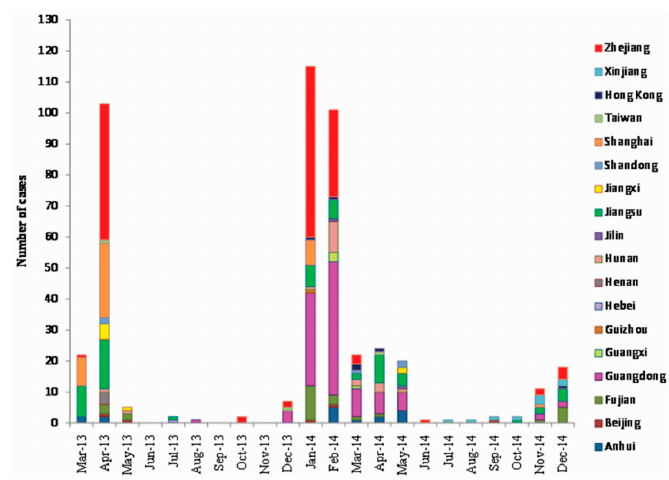
Figure 1. Monthly reported human cases of influenza A(H7N9) virus infection in China,